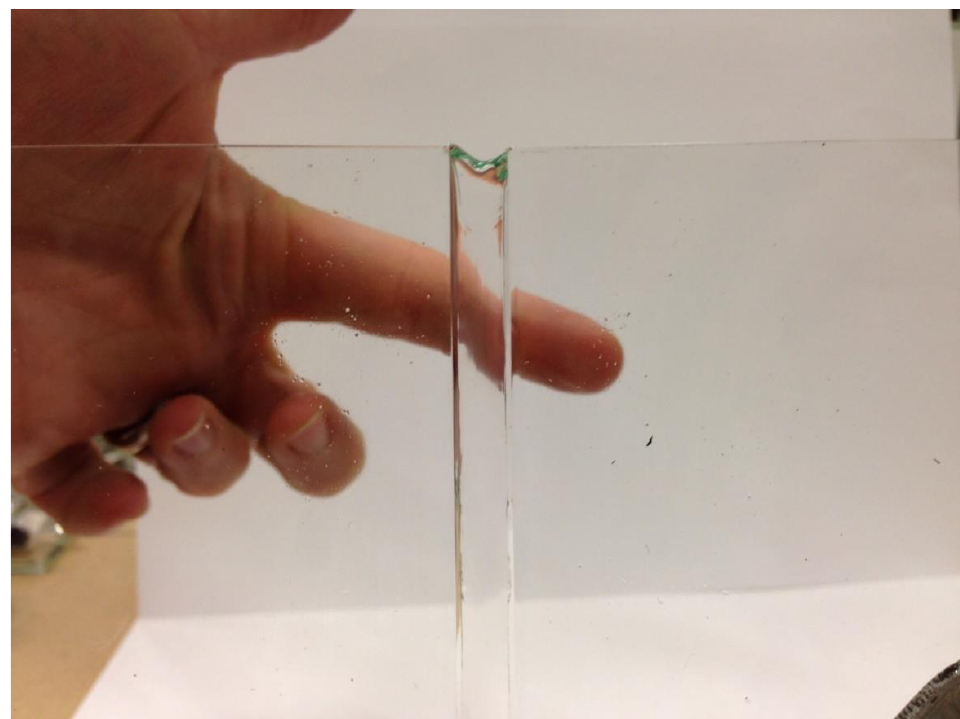
Fig. 6 picture of transparent glue.